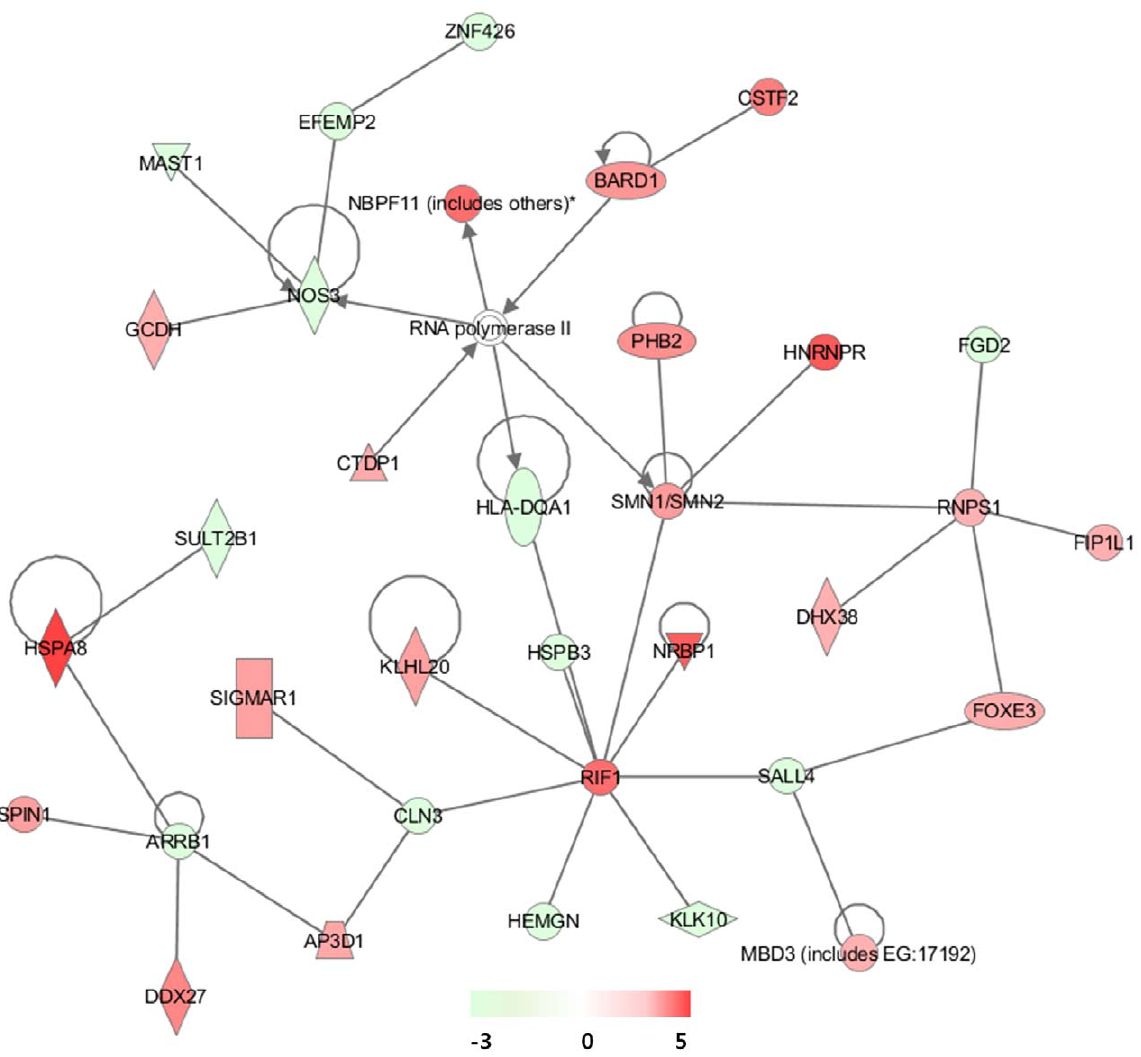
Figure 4. Highest confidence network of genes regulated by D LF. Highest confidence network of genes displaying altered expression levels in response to intracellular D LF in HEK293 cells. According to IPA, the network is relevant to ‘RNA Post-Transcriptional Modification, Embryonic Development, Tissue Development’.